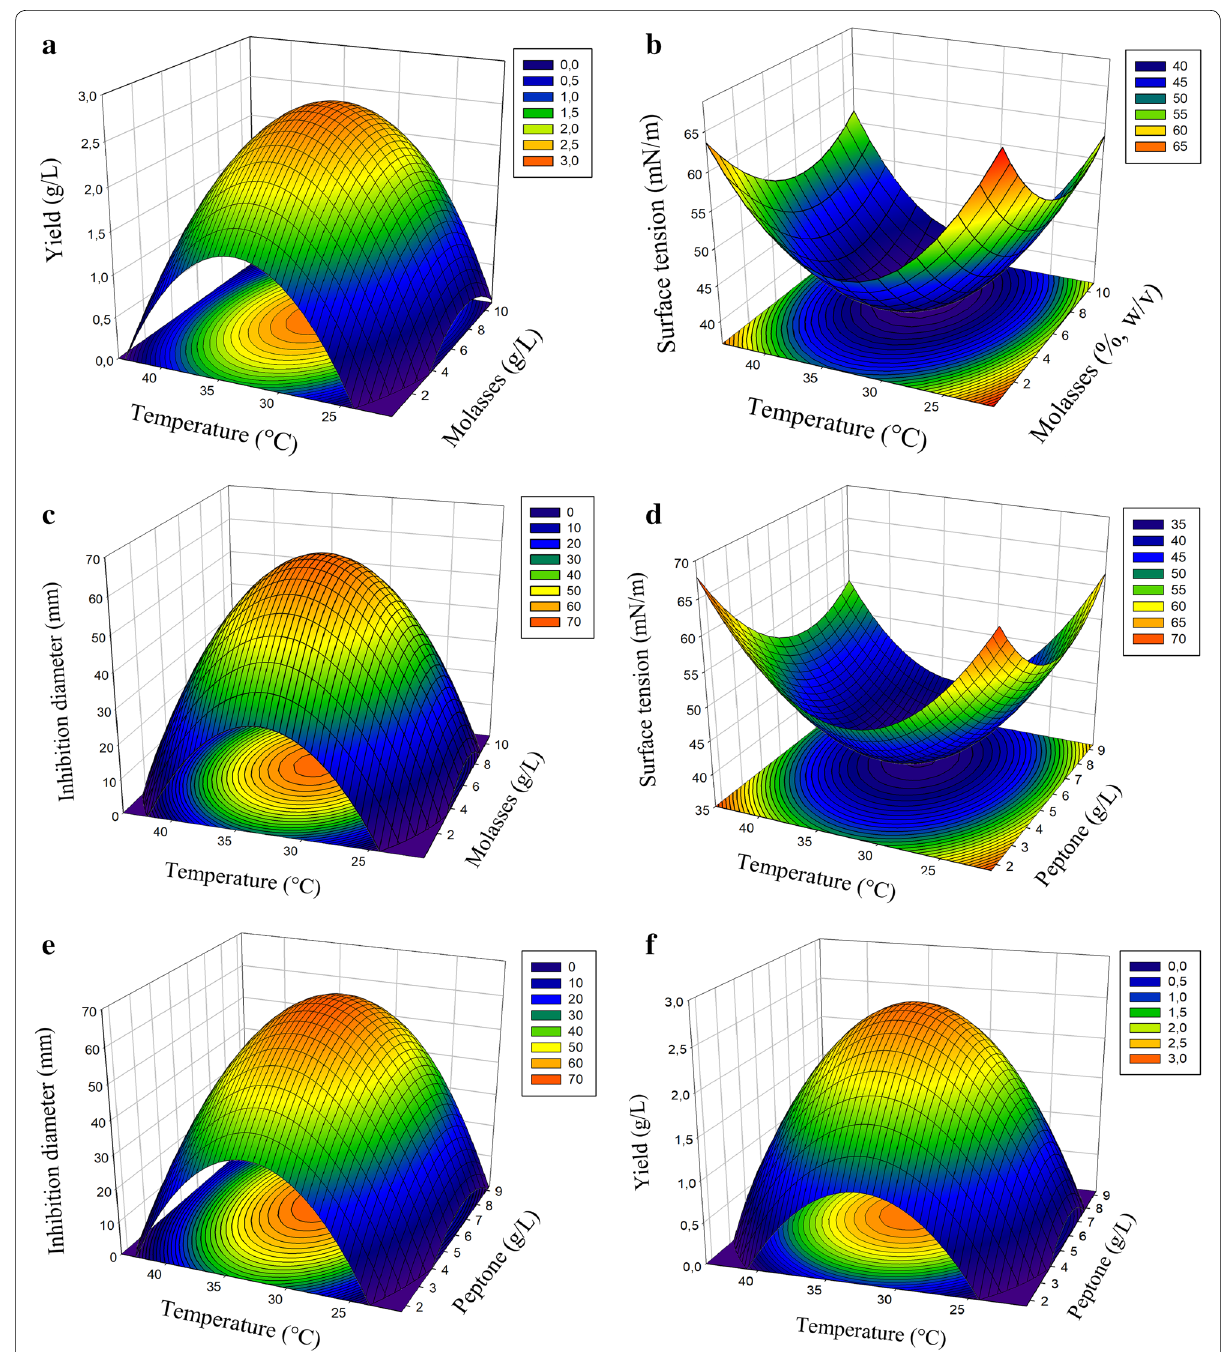
Fig. 1 3-D response surface plots showing the interactive effect of two factors on a selected response while keeping the third factor fixed at its central value. a Yield of biosurfactants as function of temperature and molasses concentration; b surface tension as function of temperature and molasses concentration; c inhibition diameter as function of temperature and molasses concentration; d surface tension as function of temperature and peptone concentration; e inhibition diameter as function of temperature and peptone concentration; f yield as function of temperature and peptone